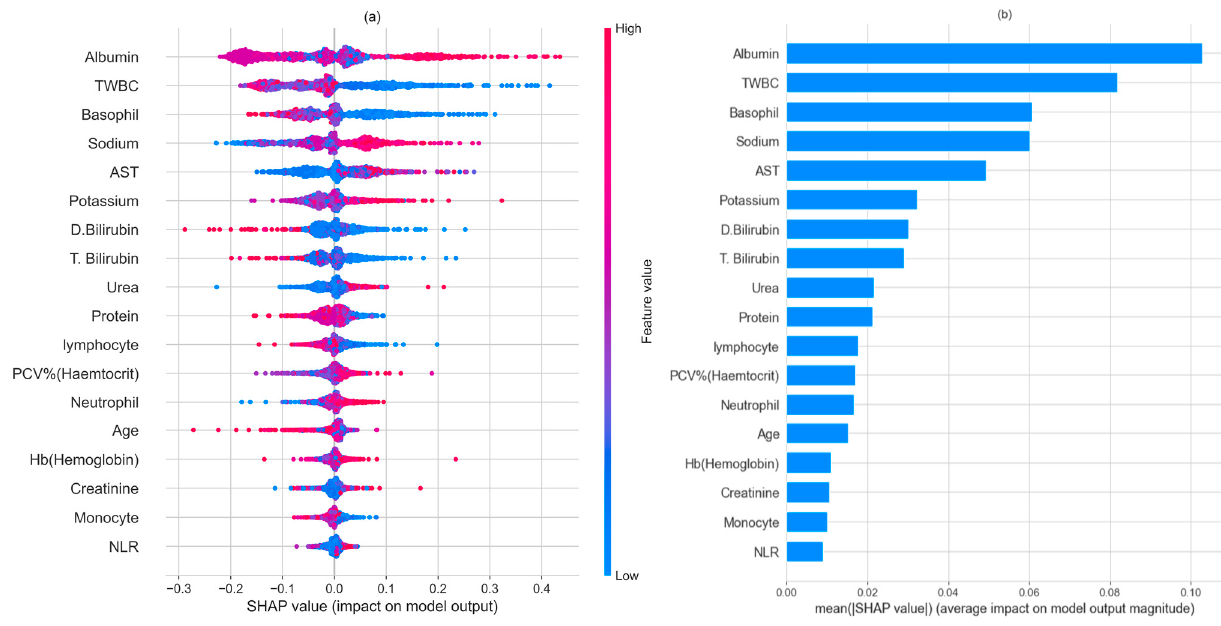
Figure 8. SHAP plots for model explainability. ( a ) bee swarm plot, ( b ) bar plot. force plot. Figure 9a describes a force plot for a patient predicted to be COVID-19